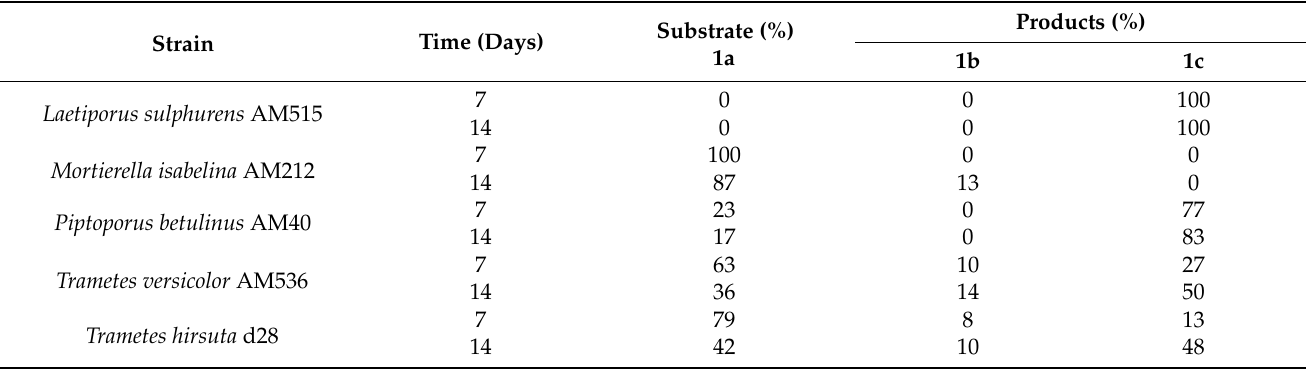
Table 1. Results of the preliminary screening of strains with peroxidase activity in relation to isosafrole ( 1a ) (percentage values according to